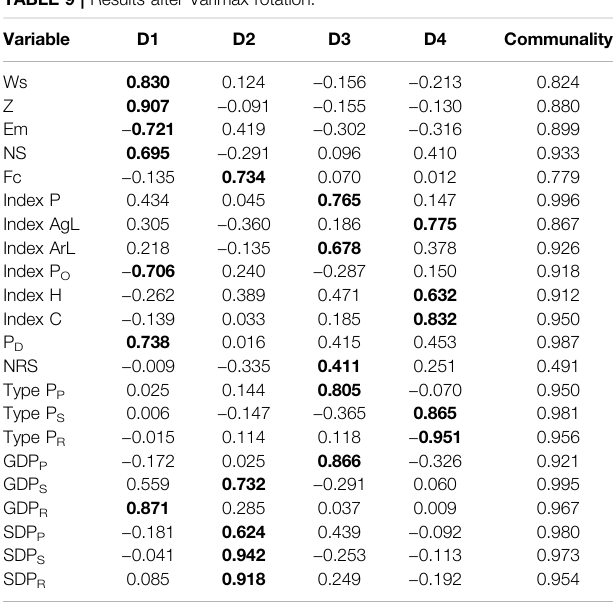
TABLE 9 | Results after Varimax rotation.